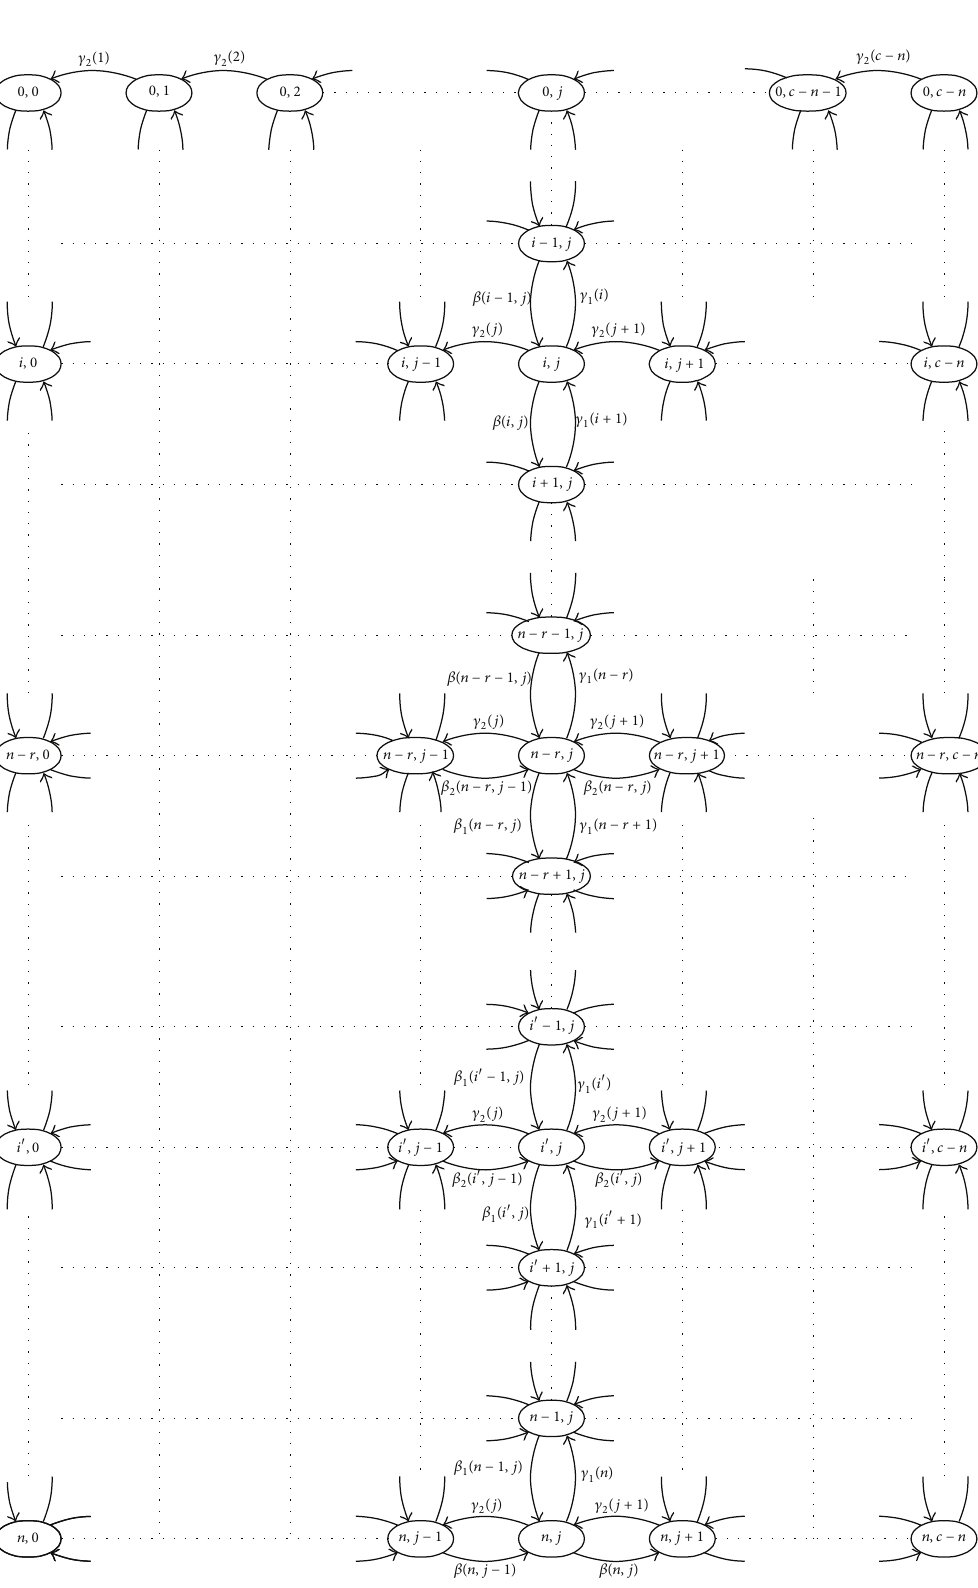
Figure 2: Transition diagram of the